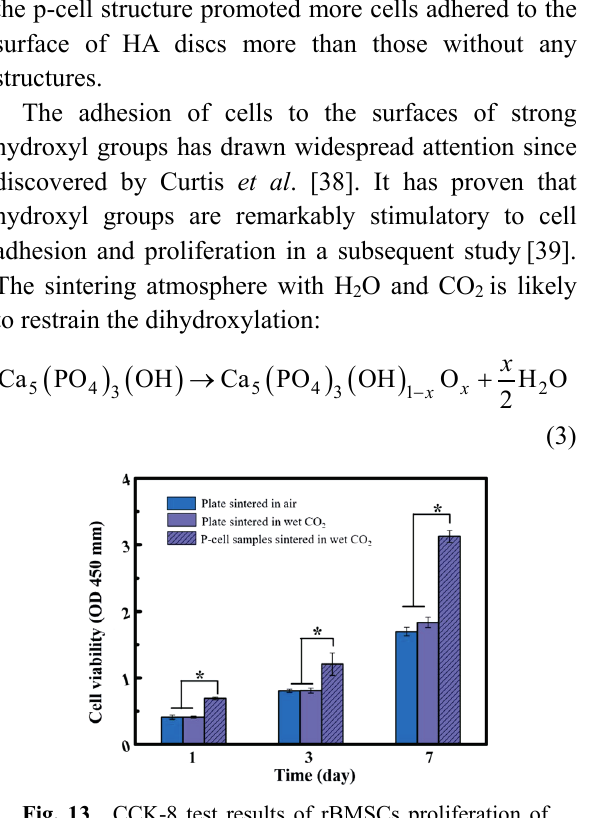
Fig. 13 CCK-8 test results of rBMSCs proliferation of HA flat plates sintered at 1300 in different atmosphere